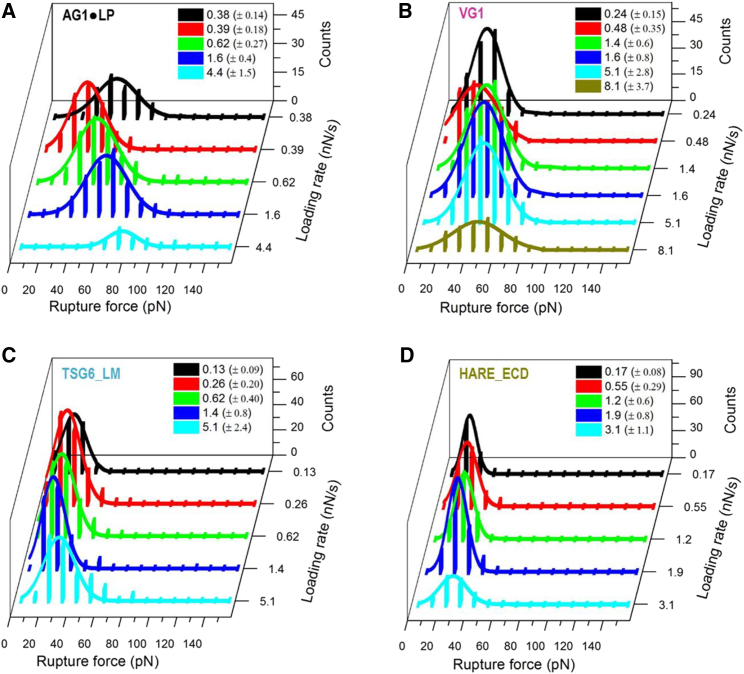
Rupture force histograms for various instantaneous loading rates (listed with grayscale/color codes as mean ± SD) for the interaction of HA with AG1⋅LP (A), VG1 (B), TSG6_LM (C), and HARE_ECD (D). Solid lines represent Gaussian fits. To see this figure in color, go online.